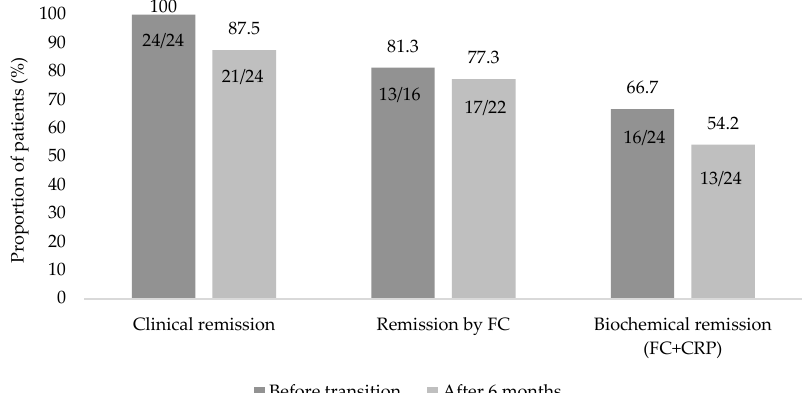
Figure 1. Algorithm of patients’ enrolment in the study.